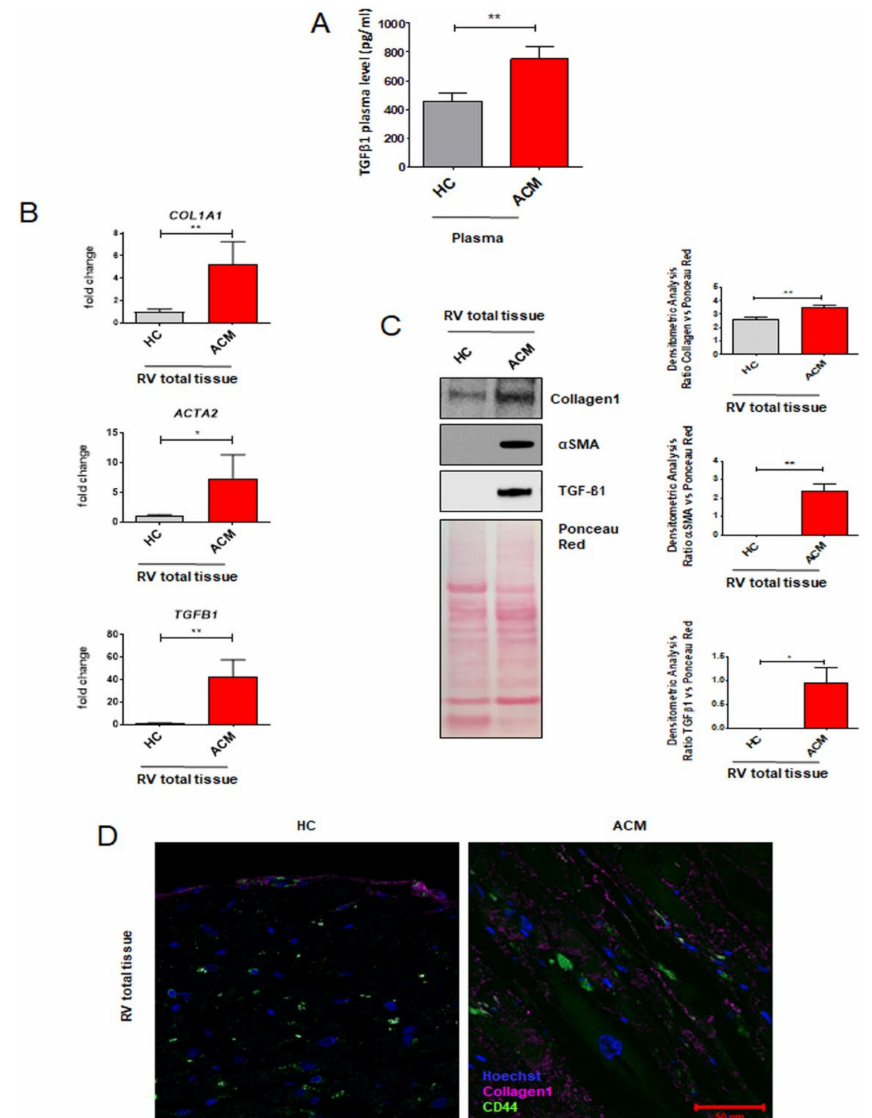
Figure 1. Fibrotic profile characterization of ACM-patient-derived tissues. ( A ) TGF- β 1 plasma levels of HC donors and ACM patients. n = 52/group. Student’s t -test: ** p < 0.01. ( B ) Expression of fibrosis-associated genes ( COL1A1, ACTA2, TGFB1 ) in total RNA extracts of RV endomyocardial bioptic samples from HC donors and ACM patients. GAPDH was used as a house-keeping gene and qRT-PCR data are presented as the fold change of target gene expression with respect to HC C-MSC. n = 4/group. Student’s t -test: * p < 0.05, ** p < 0.01. ( C ) Representative images of Western blot analysis of fibrosis-associated proteins (Collagen1, α SMA, TGF- β 1) in total protein extracts of RV endomyocardial bioptic samples from HC donors and ACM patients. Quantification of the protein abundance relative to Ponceau Red is shown in the graphs. n = 4/group. Student’s t -test: * p < 0.05, ** p < 0.01. ( D ) Representative images of immunostaining of COL1A1 and CD44 sections from biopsies from HC donors and ACM patients. Nuclei are stained with Hoechst 33342. Magnification is 63X and the scale bar indicates 50 µ m. n =